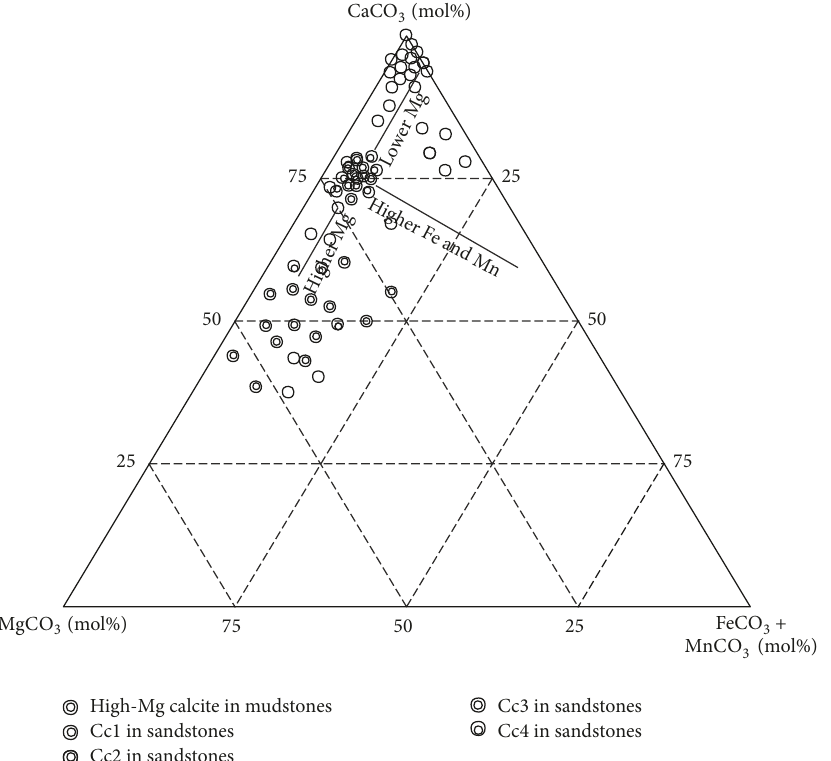
Figure 8: Geochemical characteristics of carbonate cements with different morphologies in Es of Dongying Sag.